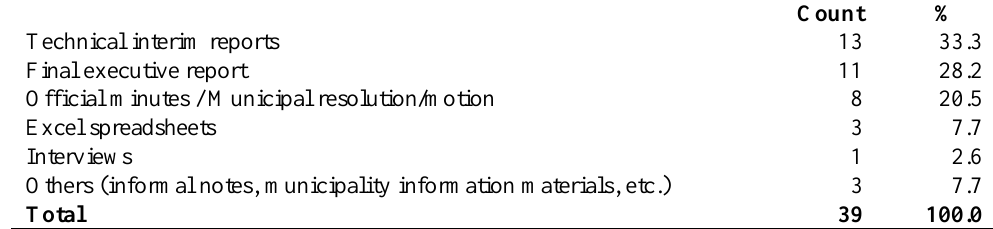
Main source of information for proposals Technical interim reports 13 33.3 Final executive report 11 28.2 Official minutes / Municipal resolution/motion 8 20.5 Excel spreadsheets 3 7.7 Interviews 1 2.6 Others (informal notes, municipality information materials, etc.) Total